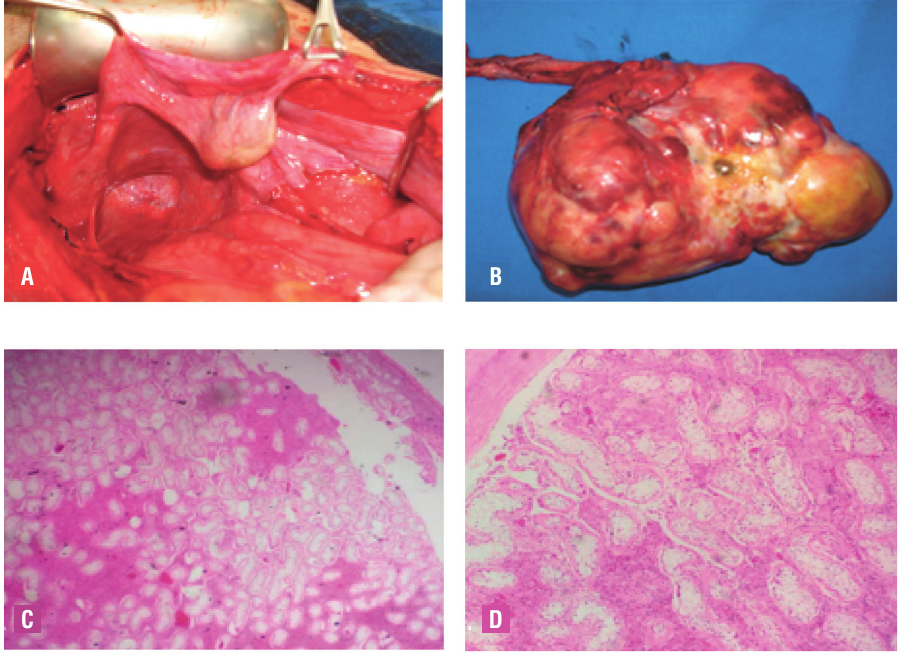
Figure 2 - Intraoperative appearance and histopathologic